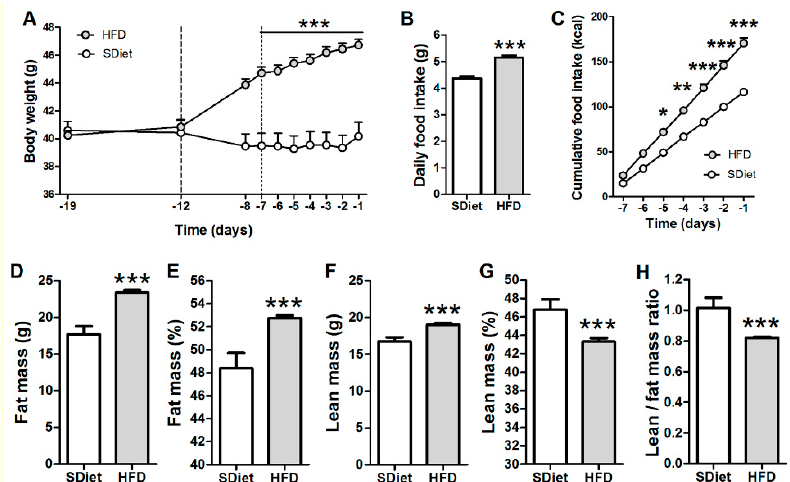
Figure 2. Induction of diet-induced obesity by high-fat-diet (HFD) in ob / ob mice. ( A ) Body weight dynamics during the pretreatment period. Vertical dotted lines define the “induction” period. Daily total ( B ) and cumulative ( C ) food intake / mouse during the sham-feeding period. Fat ( D ) and lean ( F ) mass, as well as their percentage ( E,G ) at D 0 . ( H ) Lean / fat mass ratio at D 0 . ( A,C ) Two-way RM ANOVA, both p < 0.0001, Bonferroni’s posttests *** p < 0.001, ** p < 0.01, * p < 0.05; ( B , D – H ) Mann–Whitney tests, *** p < 0.001, (mean ± SEM; standard diet (SDiet), n = 16 and HFD, n =